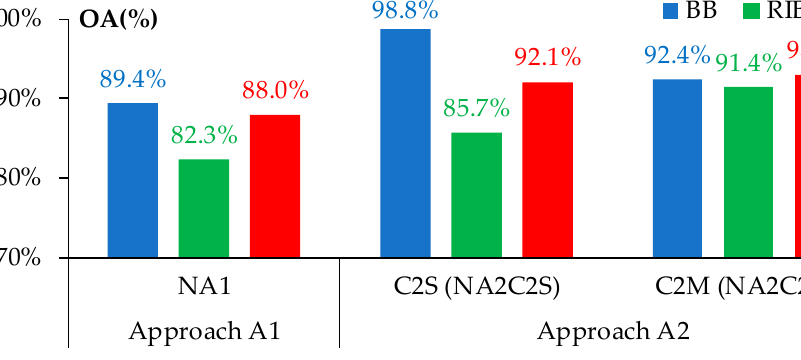
Figure 13. OA values extracted by the optimally configured networks for A1 and A2.